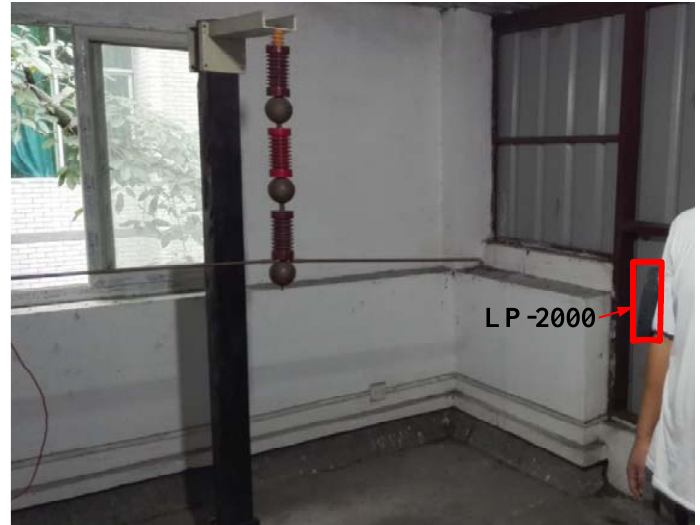
Figure 11. Measuring worksite of Type LP-2000 (in the case of an approaching human body).